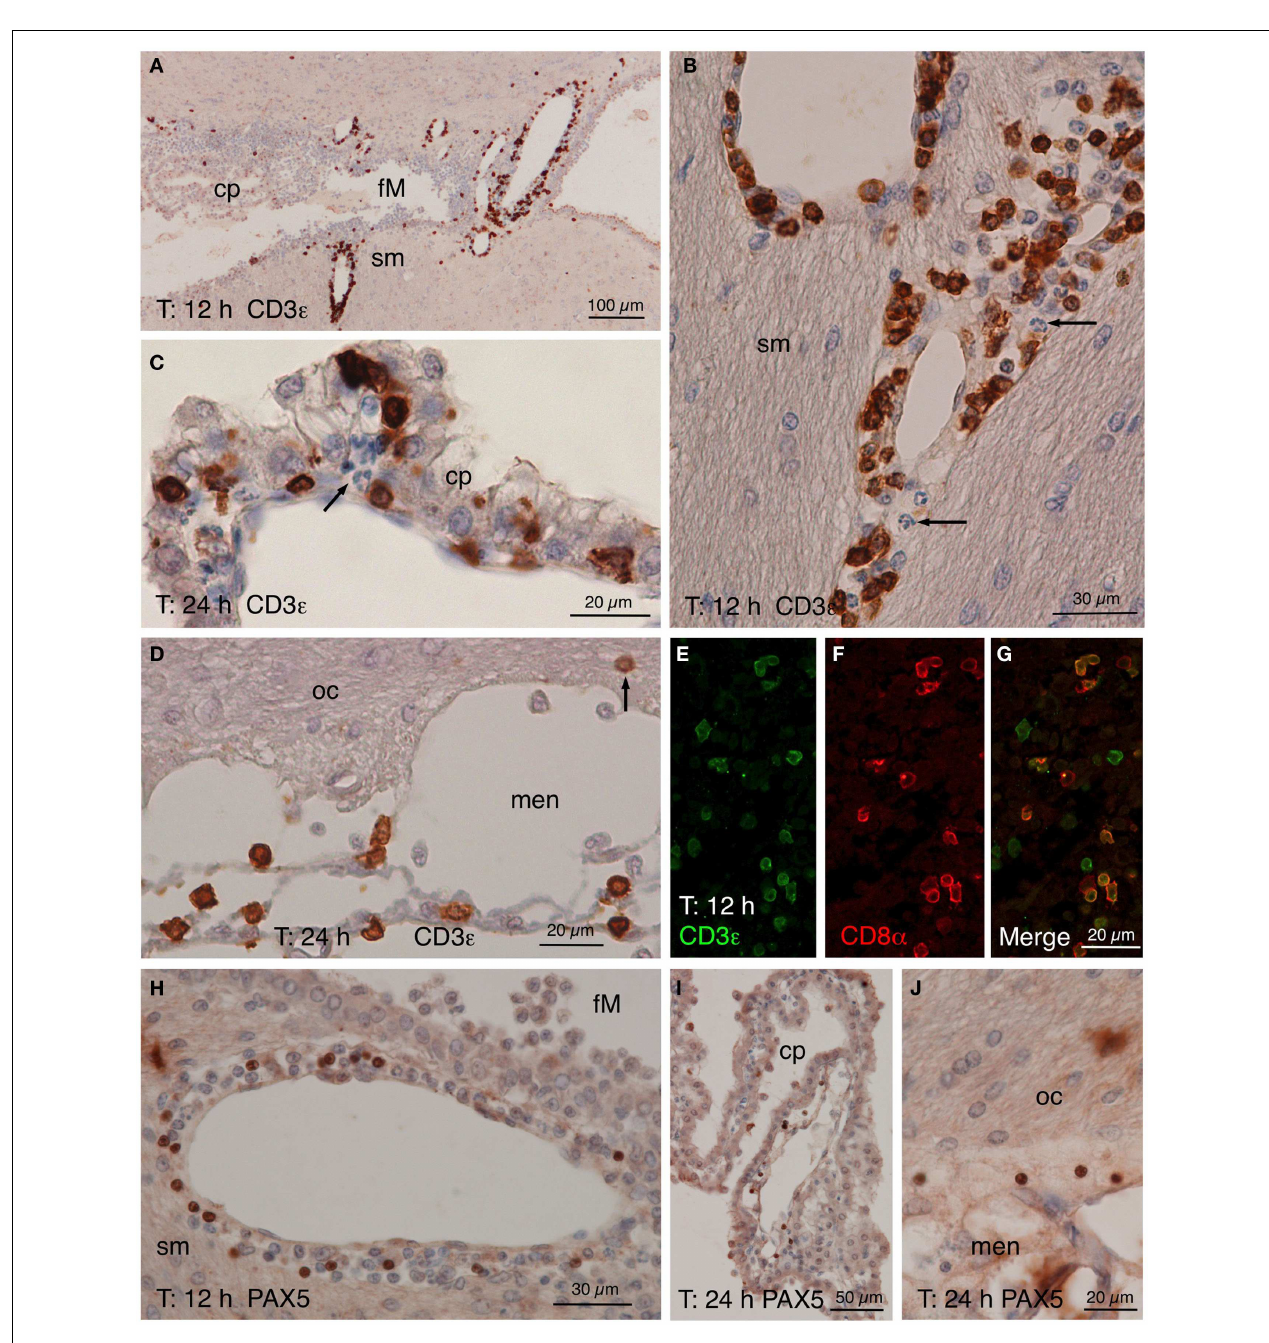
penetrate the brain parenchyma (arrow). (E–G) Double immunofluorescence of lymphocytes in a 12h post-injection brain section. Most CD3 ε -positive cells [ (E) , green] found in the perivascular spaces of the large vessels were also positive for CD8 α [ (F) , red]. (H–J) PAX5 immunostaining showing positive cells in the wall of the large vessels around the foramen of Monro [fM; (H) ], although they were not as abundant as CD3 ε -positive cells. Few PAX5-positive nuclei were also found in the choroid plexus (cp) of the injected lateral ventricle (I) as well as in the meninges (men) close to the optic chiasm [oc; (J) ]. cp, choroid plexus; fM, foramen of Monro; men, meninges; oc, optic chiasm; sm, stria